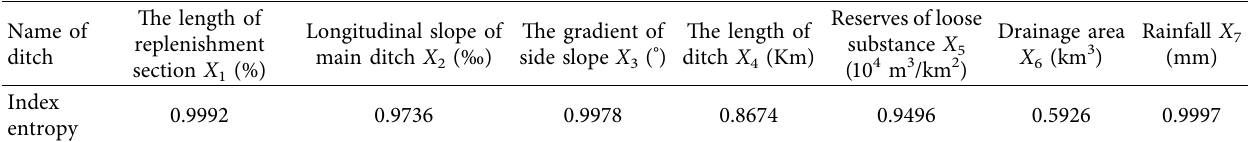
Table 4: The index entropy